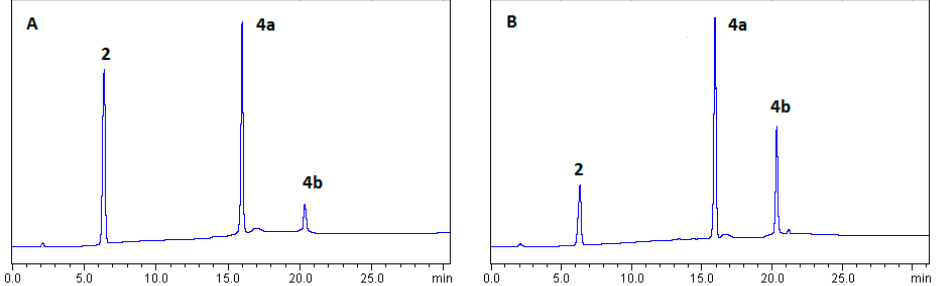
Figure 1. HPLC analysis during the reaction between bis(2-aminophenyl) disulfide and palmitic acid in tetrahydrofuran (THF), using DIC as condensing agent; ( A ) t=1d at rt; ( B ) t=3d at rt; Column: LiChrospher ® 100 RP-18 (5 µm) LiChroCART ® 250-4; Mobile phase: THF/H 2 O; Gradient: 50% THF to 100% THF in 30 min; Flow rate: 1ml/min; Detection at 254 nm.